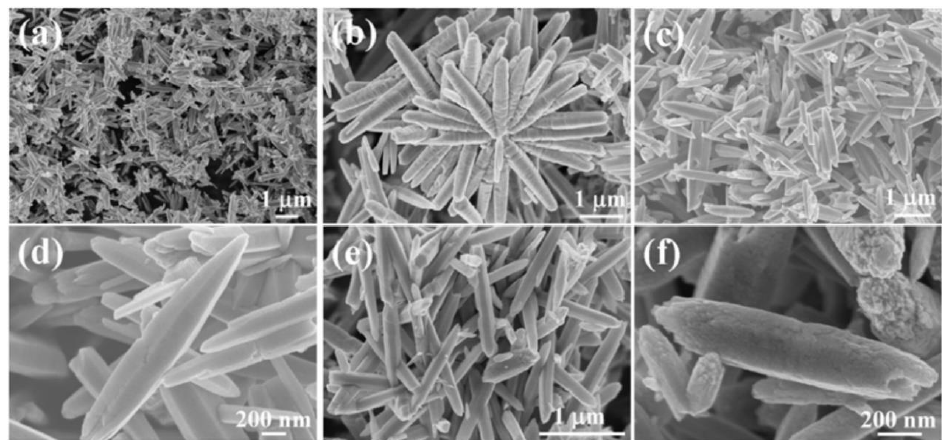
Figure 72. SEM images of ZnO products synthesised from zinc acetylacetonate hydrate with the Zn/HEPES molar ratio of 1:2 under different pH values: 7.4 ( a , b ); 8.4 ( c , d ); 9.4 ( e , f ). Products synthesised by the microwave and ultrasonic wave combined method. Reprinted from [844], Copyright (2013), with permission from Elsevier [OR APPLICABLE SOCIETY COPYRIGHT OWNER]. All rights reserved. In order to re-use permission must be obtained from the rightsholder. An example of a publication showing results of obtaining ZnO with the use of the microwave induced combustion process is the paper by Cao et al. [847]. In this paper, an aqueous solution of zinc nitrate with an addition of urea was used as a reaction precursor. The samples were placed in an ordinary microwave oven and subjected to microwaves. After boiling, evaporating, and concentrating, the precursor rapidly foamed up, deflagrated, and released heat and gases. Synthesis products were heterogeneous ZnO microstructures, the morphology of which changed depending on the urea/Zn 2+ molar ratio (1:1, 5:3, and 3:1), which is presented in Figure 73. The effect of the high temperature of the microwave induced combustion process was that the vast majority of the obtained synthesis products were ZnO microstructures.